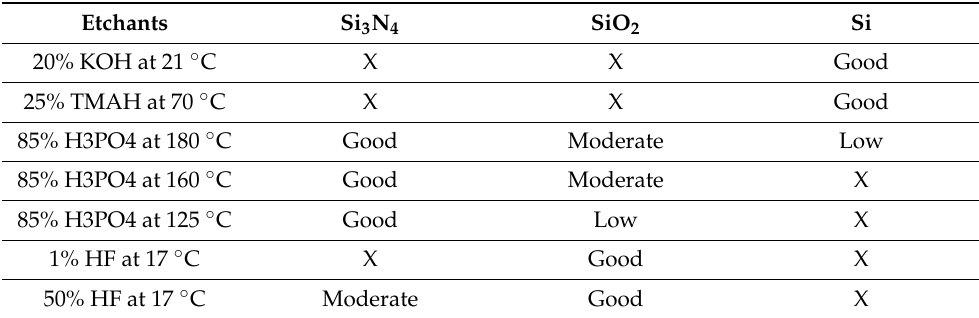
Table 2. Qualitative, relative etching characteristics of used materials in used etchants. X stands for not etching or insignificant etch